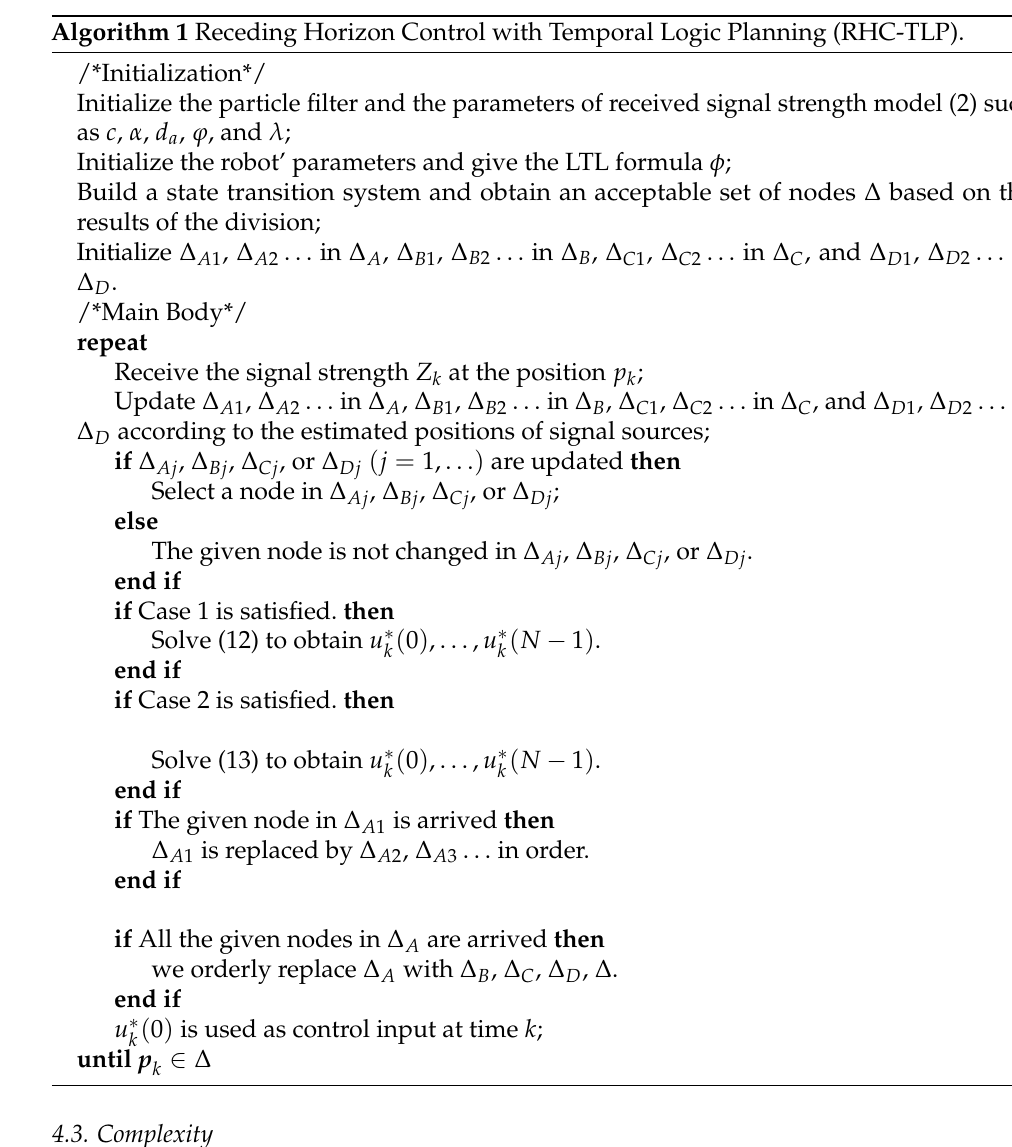
Algorithm 1 Receding Horizon Control with Temporal Logic Planning (RHC-TLP).